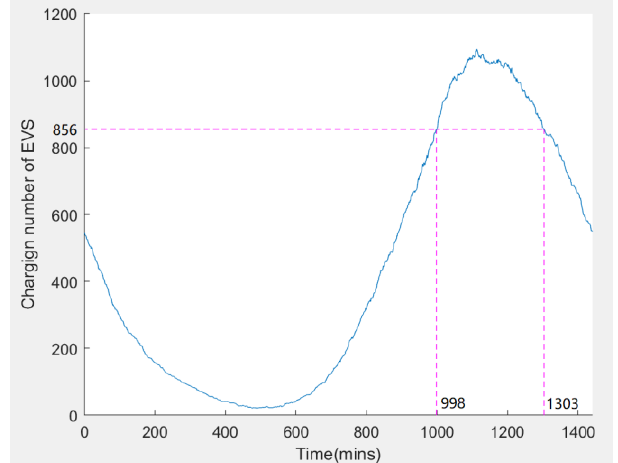
Figure 6. The mean number of charging electric vehicles (EVs).